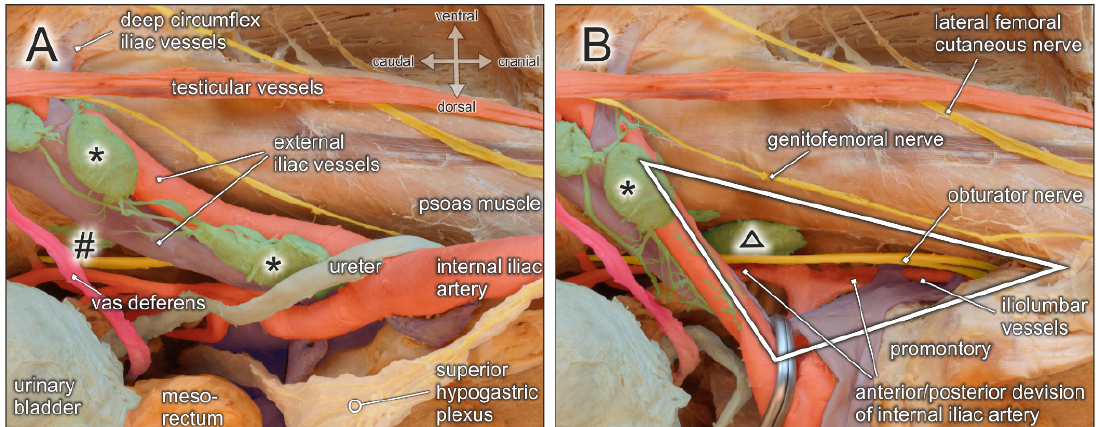
Figure 6. Topographic anatomy of the pelvic sidewall. Medial view of a right male hemipelvis. The urinary bladder and the mesorectum/rectum are shifted to the left side. ( A ) External iliac lymph nodes (asterisks), obturatory lymph nodes (hashtag), and interconnecting lymphatic vessels are exposed. Structures at risk during lymphonodectomy are the genitofemoral nerve running lateral along the external iliac artery, testicular vessels and the vas deferens, the obturator nerve and vessels extending throughout the obturator fossa, the ureter crossing the proximal external iliac vessels, and the hypogastric nerve. ( B ) External iliac vessels (clamp) and the ureter are shifted medially to the contralateral/left side to expose the triangle of Marcille (white triangle) limited by the fifth lumbar vertebra/promontory, the medial border of the psoas muscle, and the lateral aspect of the sacral concavity. Structures at risk during removal of lymph nodes (black triangle) within the triangle of Marcille are the proximal segment of the obturator nerve, the lumbosacral trunk (L4–L5), and the anterior and posterior division of the internal iliac vessels, in particular the iliolumbar vessels.